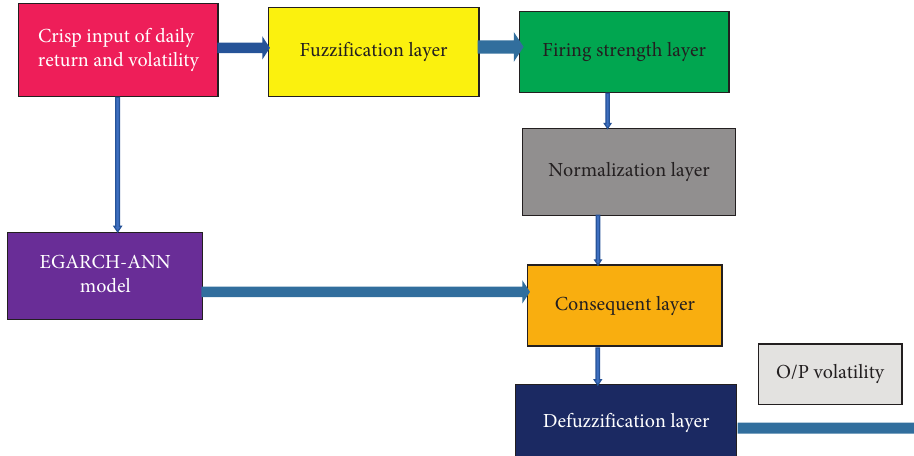
Figure 1: Framework of the fuzzy-EGARCH-ANN model.